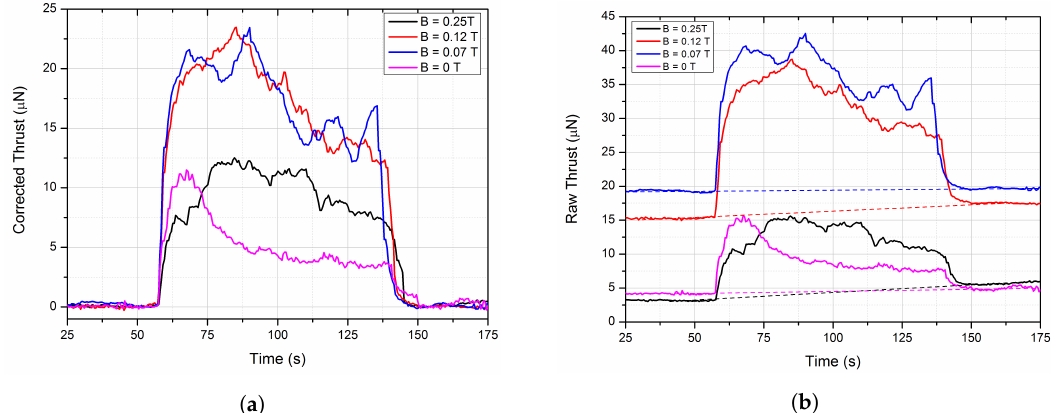
Figure 10. Thrust versus time measurement for a single firing cycle at different magnetic inductions ( a ). Drift corrections are shown as dashed lines ( b ).